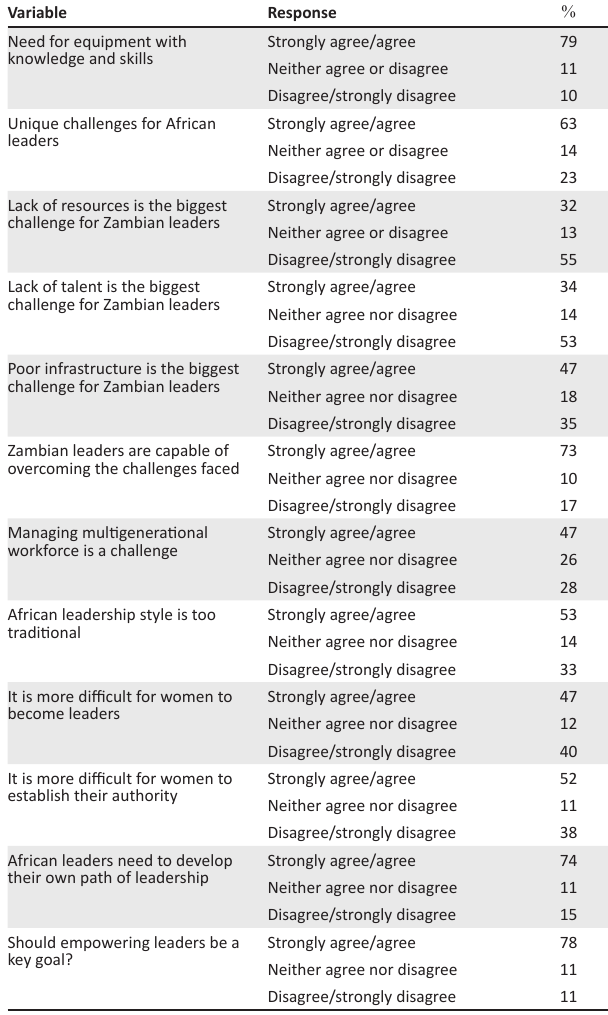
TABLE 4: Likert-scale responses on challenges for African leaders. TABLE 3: Experience in a leadership position global experience cross-